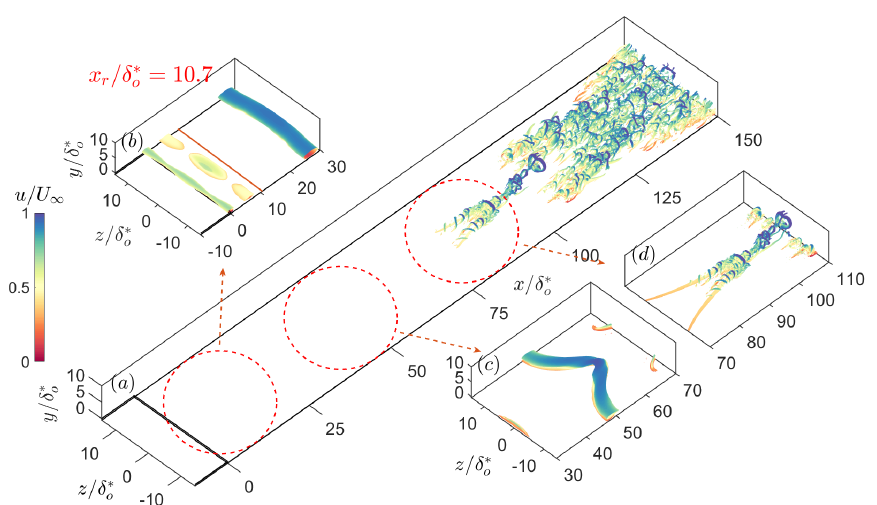
Figure 12. Small step, variable U e . Isosurfaces of λ 2 , colored by the magnitude of streamwise velocity,